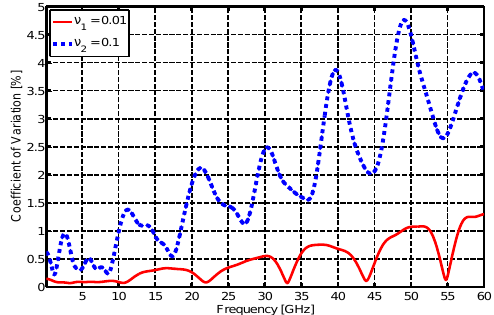
Figure 3: SE coefficient of variation (i.e. rate between SE std and SE mean considering 10 CST (cid:114) simulations with random location of spherical inclusions; r = 0 . 050 mm) for various volumetric rate ν 1 = 0 . 01 and ν 2 = 0 . 10 . Volumetric rate Table 2: Mean and standard deviation (std) of SE coefficient of variation (CV) over the whole frequency bandwidth (i.e.